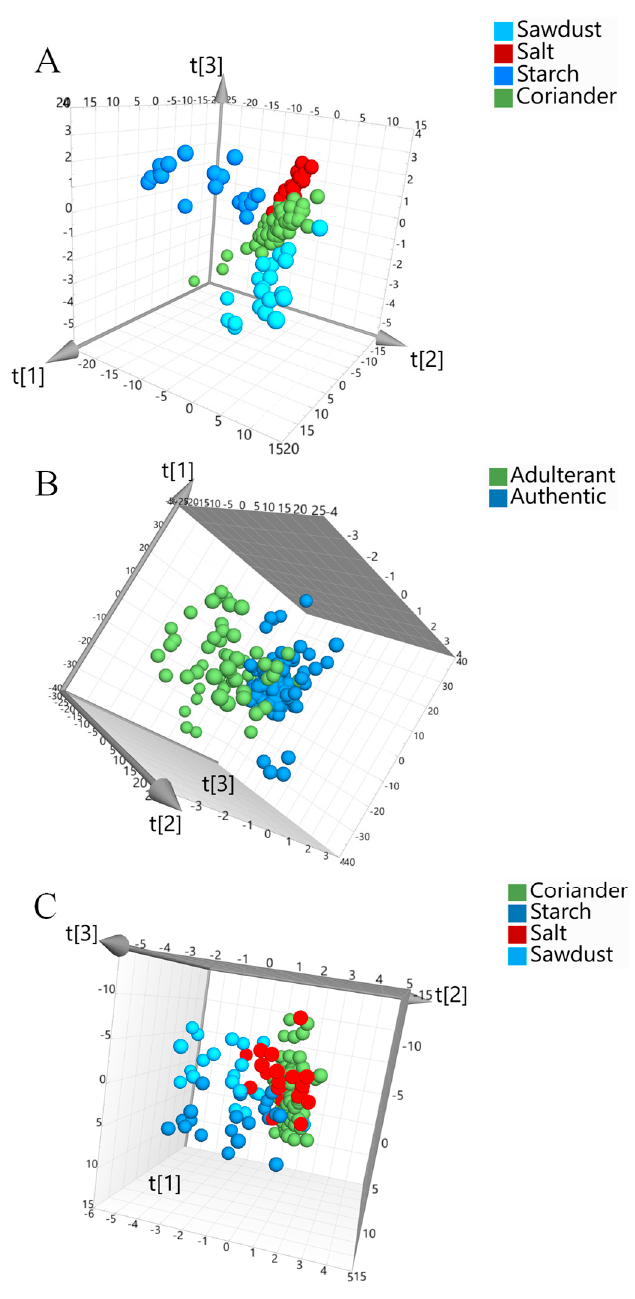
Figure 2. The best classification models obtained for each NIRS instrument developed using SIMCA 15 software; ( A ) Spectra obtained from the Thermo iS50 benchtop instrument; a multiclass, PLS-DA model with SNV pre-processing applied (R 2 = 0.99, Q 2 = 0.70). ( B ) The portable Flame-NIR obtained data; a PLS-DA, two-class model with no spectral pre-processing applied (R 2 = 1.0, Q 2 = 0.78). ( C ) Data obtained from the handheld SCiO device, pre-processed with SNV and 1DER; a PLS-DA, multiclass model (R 2 = 0.99. Q 2 = 0.52).